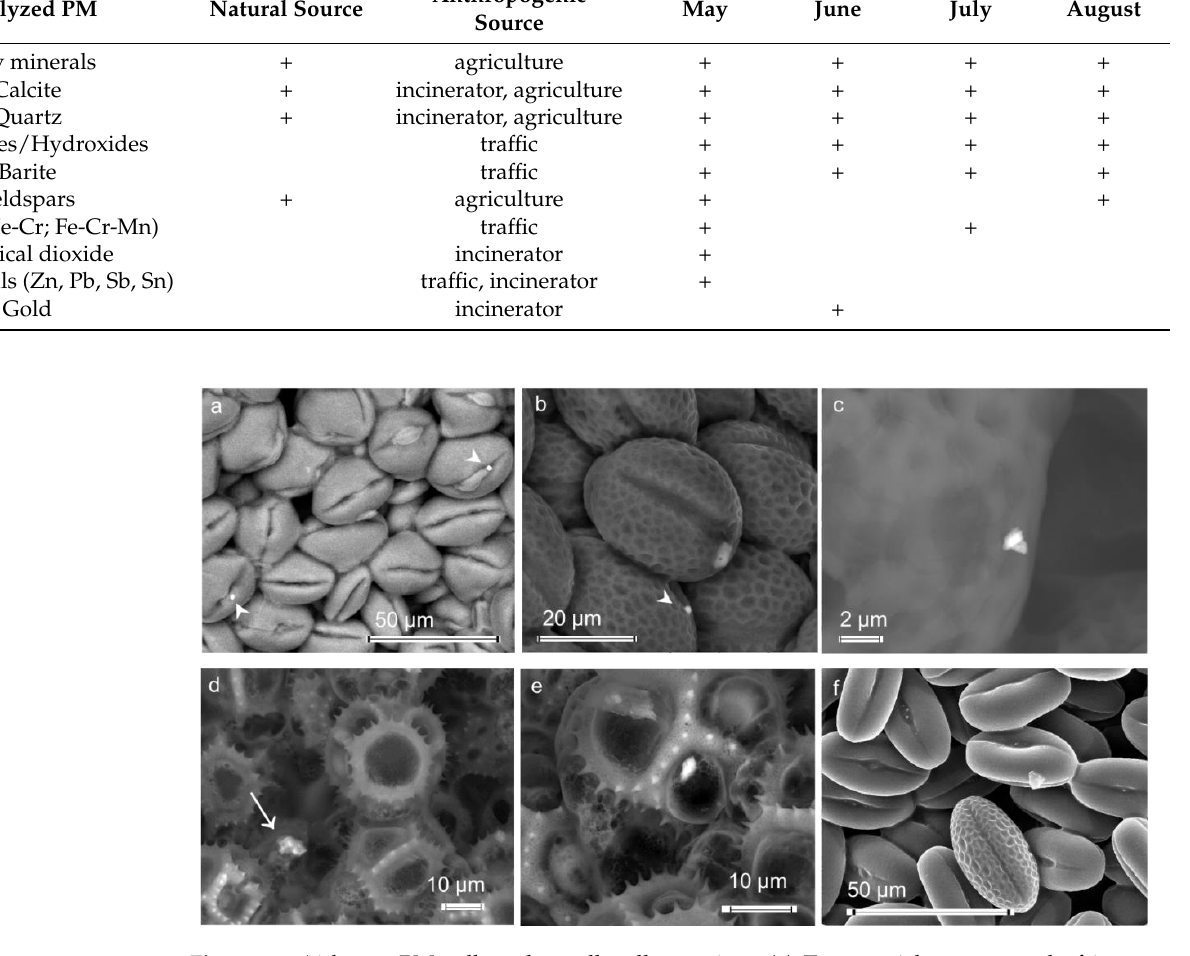
Table 1. Mineralogical phases and other PMs contaminating bee pollen collected in different months.